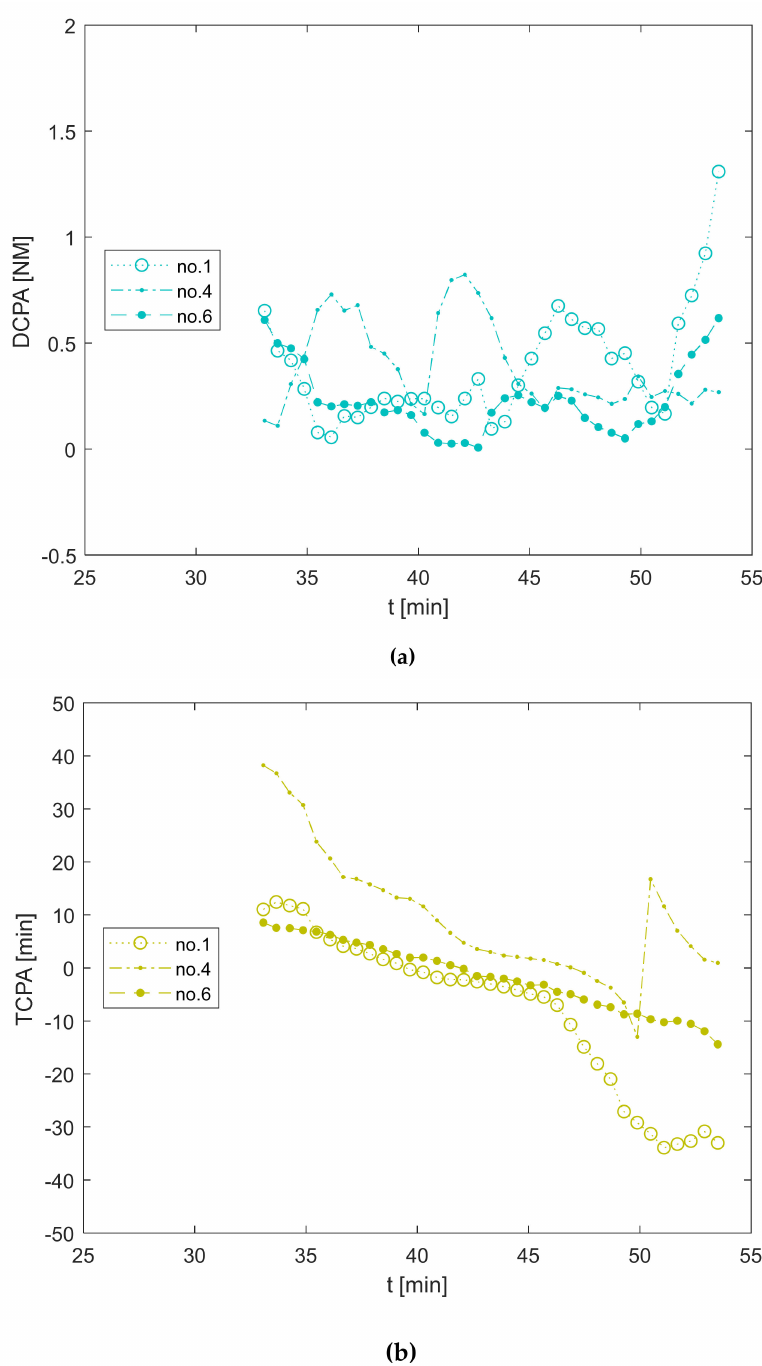
Figure 7. ( a ) DCPA and ( b ) TCPA of scenarios no.1 ( ship-i : ship-1, ship-j : ship-2), no.4 ( ship-i : ship-1, ship-j : ship-5), and no.6 ( ship-i : ship-2, ship-j :